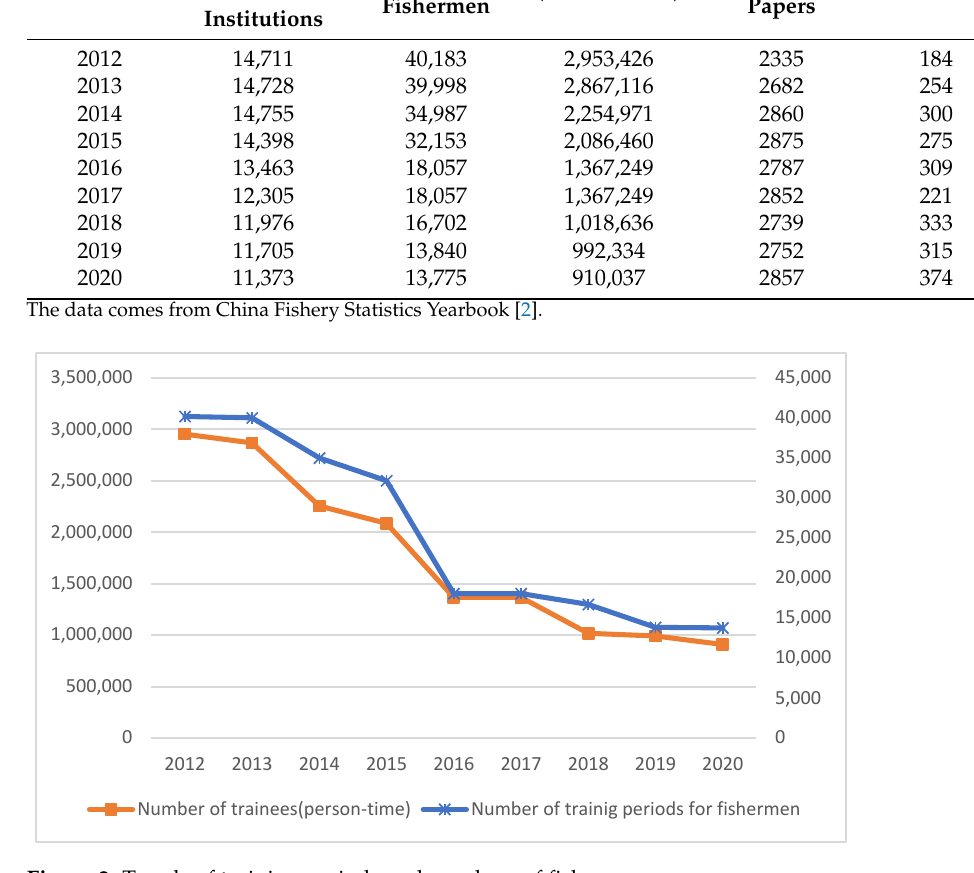
Figure 2. Trends of training periods and numbers of fishermen.